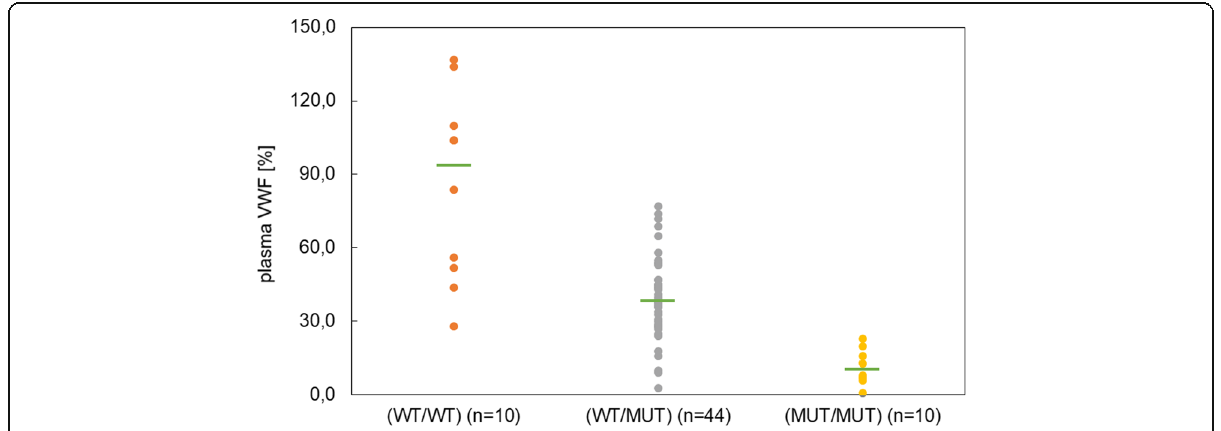
Fig. 5 Correlation of plasma von Willebrand factor with the corresponding genotype in the Kromfohrländer breed. Von Willebrand factor and the three different genotypes (wild-type (WT/WT), heterozygous (WT/MUT), homozygous (MUT/MUT)) are shown for 64 Kromfohrländer dogs. Median is indicated in green and for wild-type 94.0%, for heterozygous 38.5% and for homozygous 10.5%. Significance between plasma vWF and the different genotypes was determined by a Kruskal-Wallis test (H = 29.5388; p -value < 0.00001; df = 2). The result is significant at p <